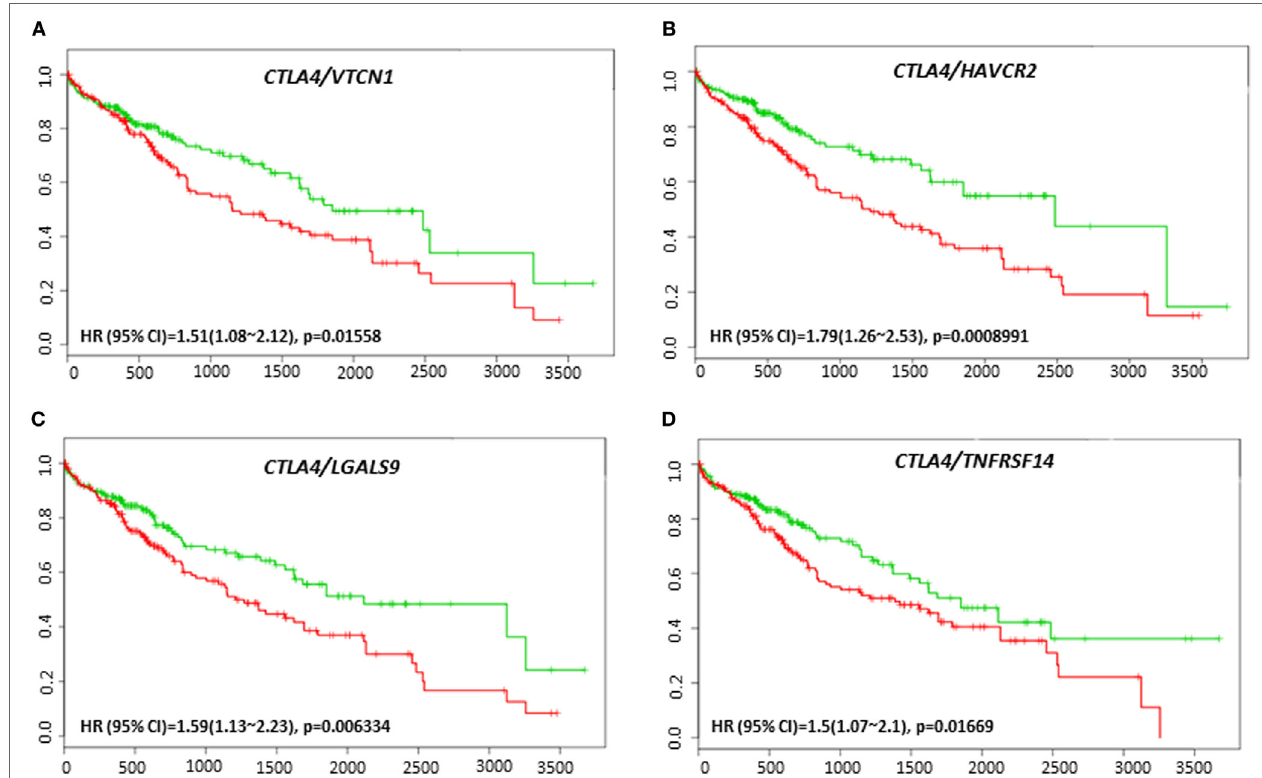
FigUre 9 | Relationship of immune modulators in combination with CTLA-4 and survival in HCC patients. Kaplan–Meier survival curves generated using the SurvExpress for the analysis of survival and gene expression of (a) CTLA-4/VTCN1 , (B) CTLA-4/HAVCR2 , (c) CTLA-4/LGALS9 , and (D) CTLA-4/TNFRSF14 in HCC patient samples. Green curve represents low-risk group, while red curve represents high-risk group. The study time (months) is presented on the x -axis. The insert shows the hazard ratio, confidence interval, and Log-Rank Equal Curves p value. Markers ( + ) represent censoring